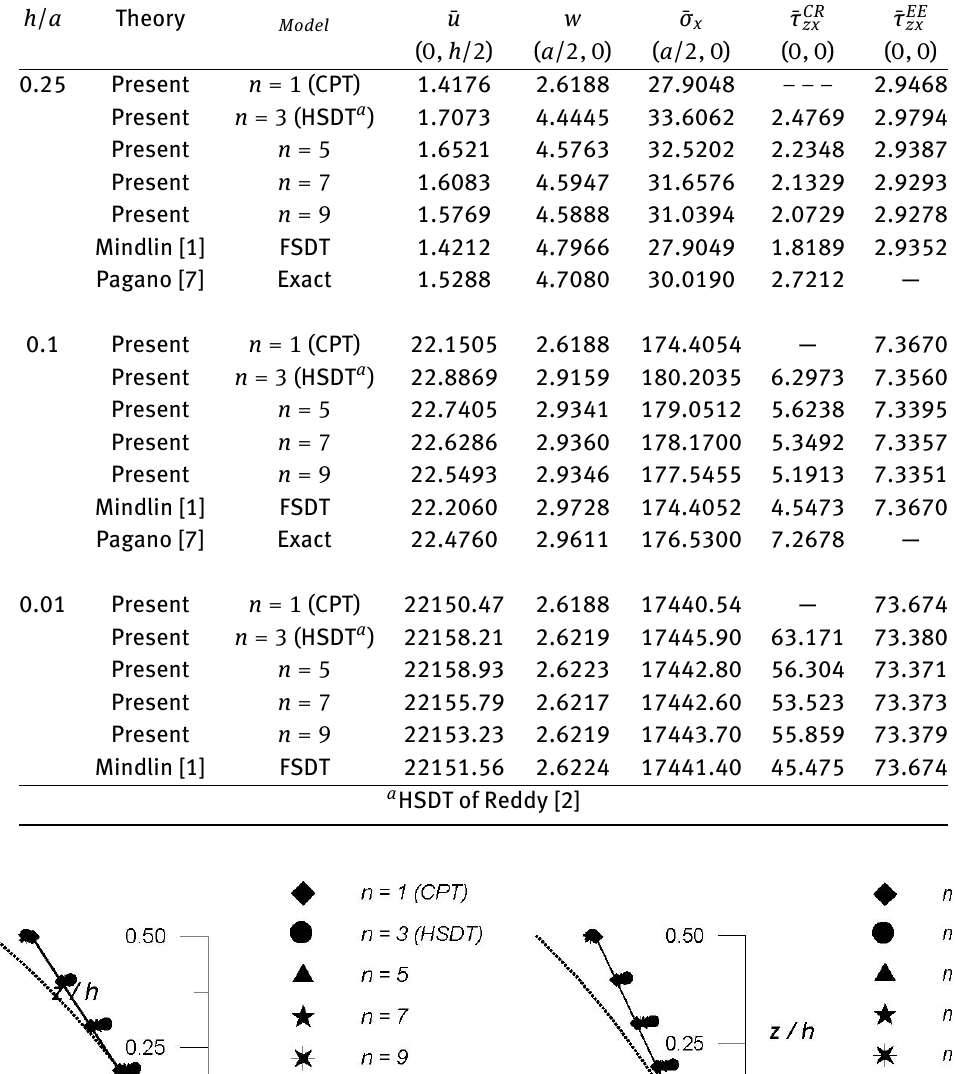
Table 1: Comparison of normalized displacements and stress for two layered (0 ∘ /90 ∘ ) un-symmterically laminated composite plates in cylindrical bending (Material 1).